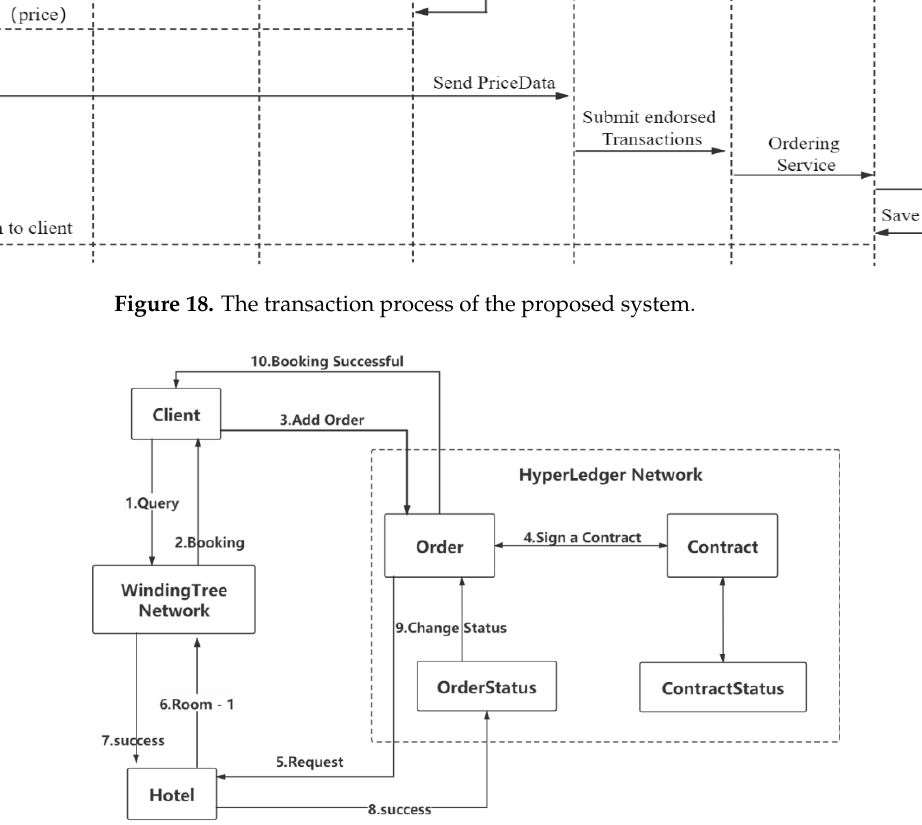
Figure 19. Booking process workflow in the proposed system.